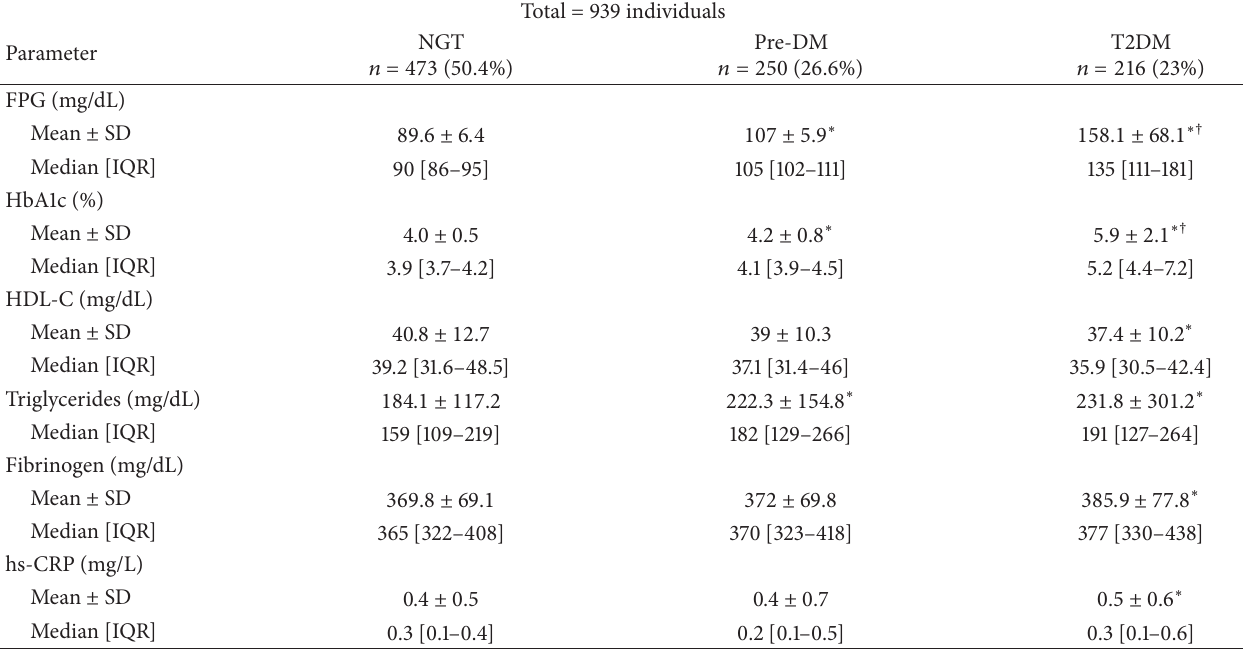
Table 2: Biochemical characteristics of the overall sample categorized according to glucose tolerance